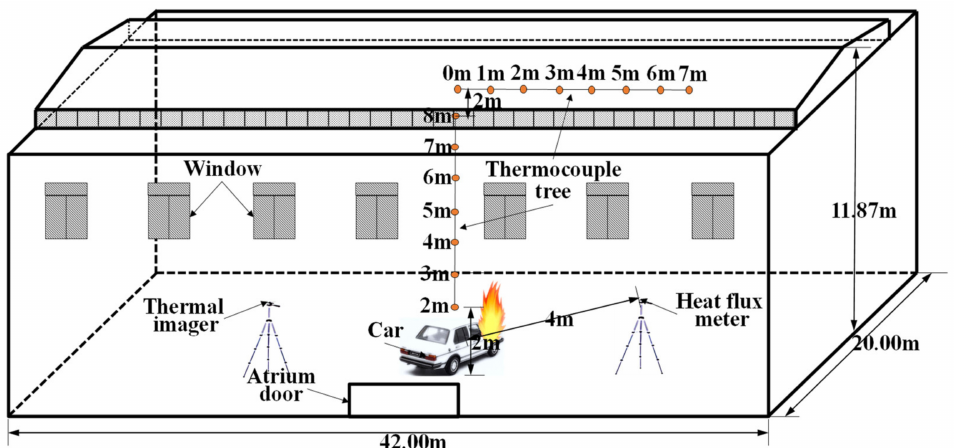
Figure 5. Experimental